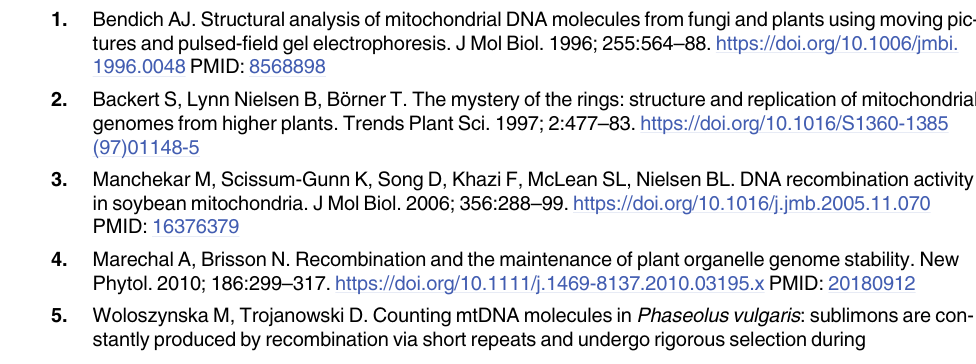
S9 Fig. No significant change in cpDNA copy number in recA3 radA . Quantification by qPCR of the relative copy number of the cpDNA genes ClpP and NadH in recA3-2 radA-1 double mutants. The results are the mean from three independent plants, ± SD . S1 Table. List of primers and numerical values underlying graphs shown in Figs 4B,